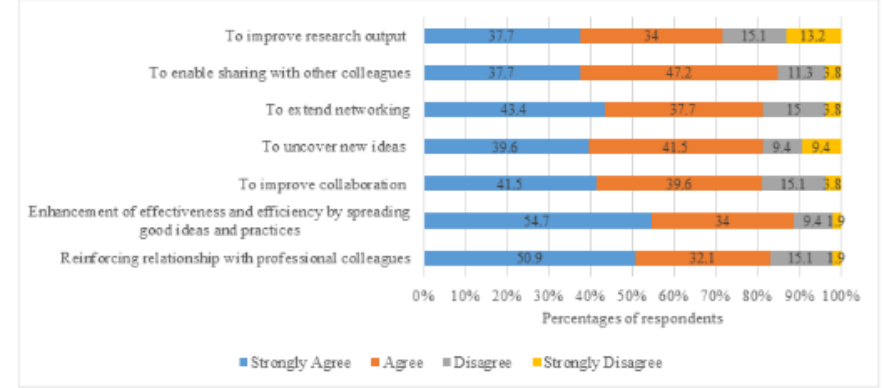
Figure 3 Benefits of knowledge sharing among health sciences librarians in Africa.